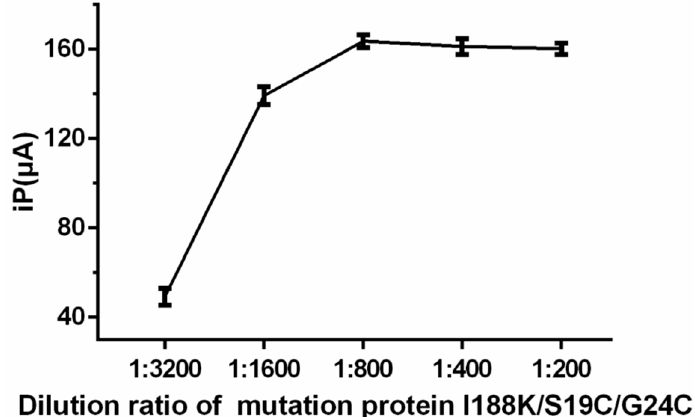
Figure 4. The CV peak current values of different mutation protein I188K/S19C/G24C concentrations.